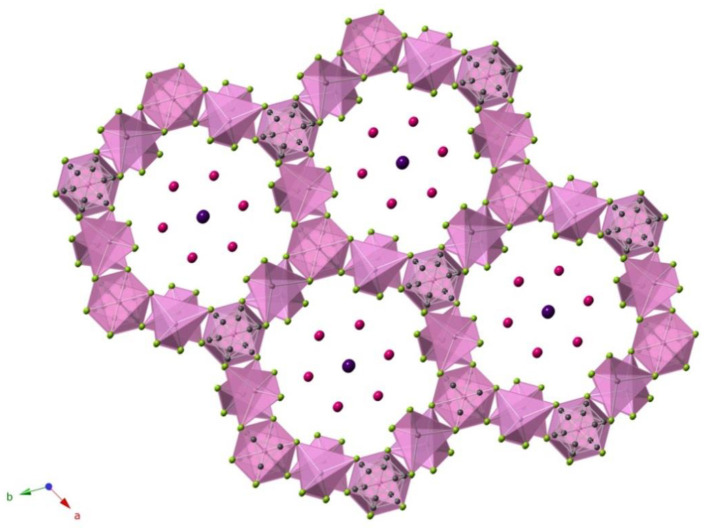
A view on the structure of (K3I)[InB12(InSe4)3] salt-inclusion compound, which was obtained using KI flux (Guo et al., 2016).